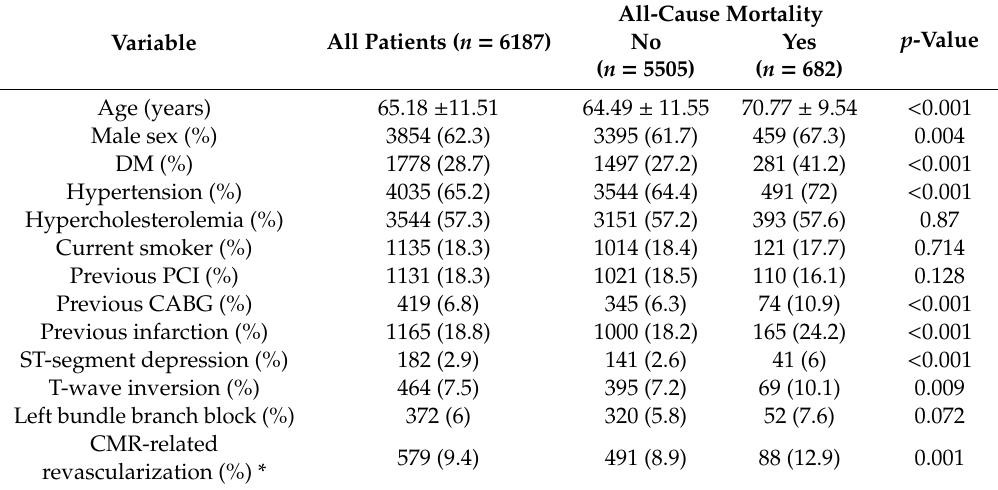
Table 1. Baselinecharacteristicsofthewholeregistryandofpatientswithandwithoutall-causemortality.